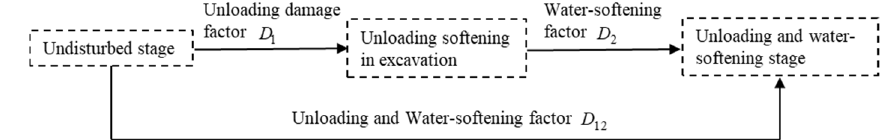
Figure 7. Different damage factors of surrounding rock.